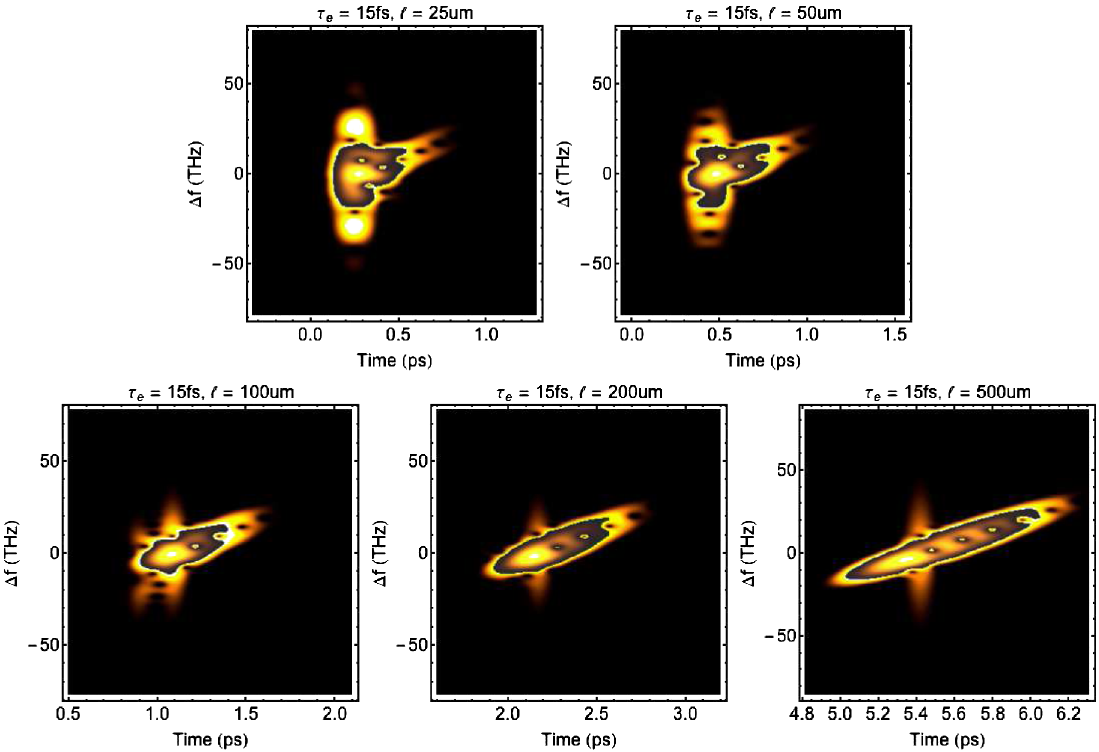
FIG. 6. Simulation results showing the effect of various crystal length on the signal from a 15 fs